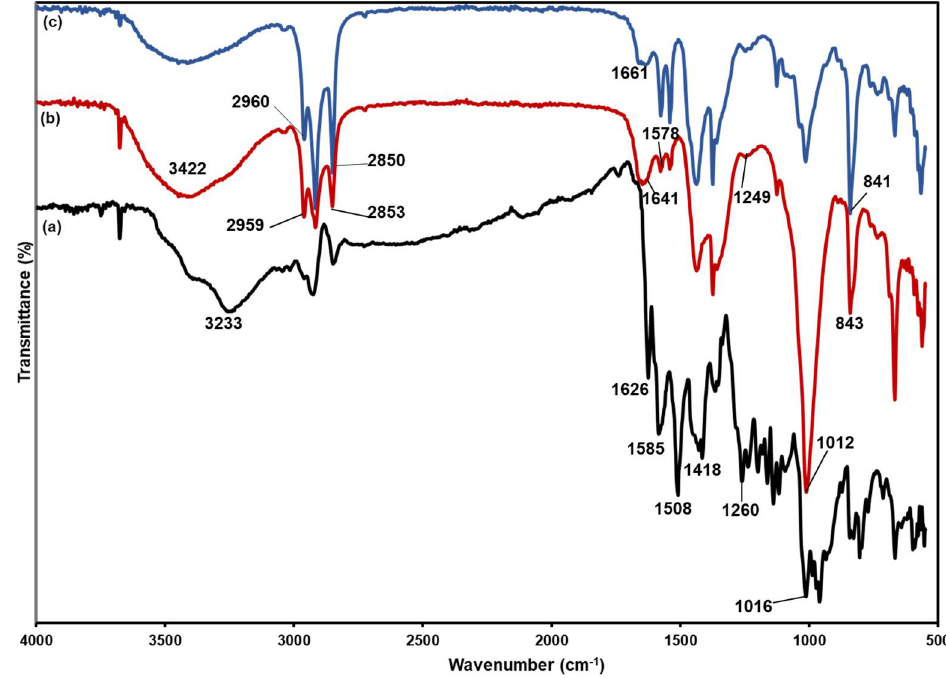
Figure 6. FTIR spectrum of ( a ) curcumin, ( b ) LC and ( c ) NRL.